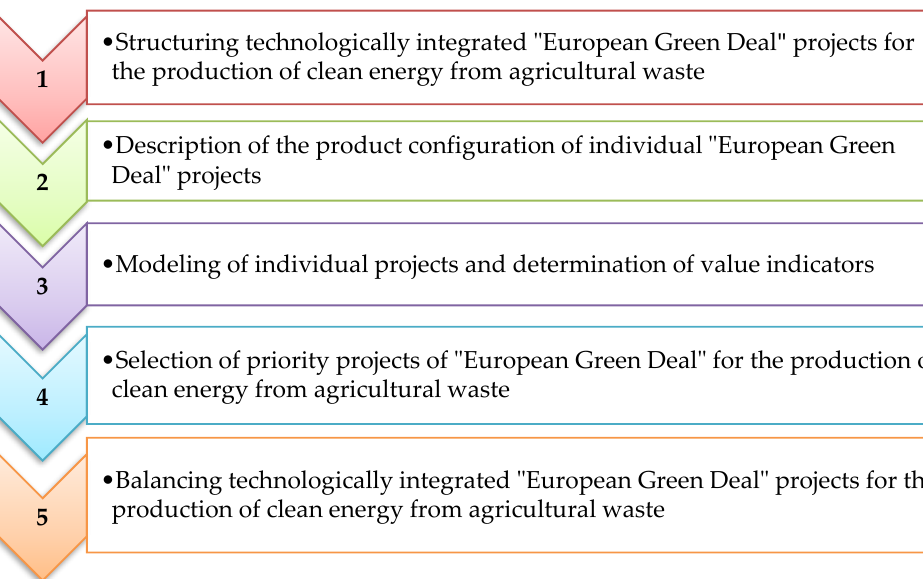
Figure 1. Stages of the method of coordination of configurations of technologically integrated “European Green Deal” projects for the production of clean energy from agricultural waste in the re- gion.